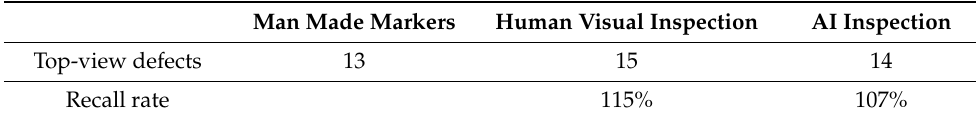
Table 20. Top-view defect inspection by AI and human. Man Made Markers